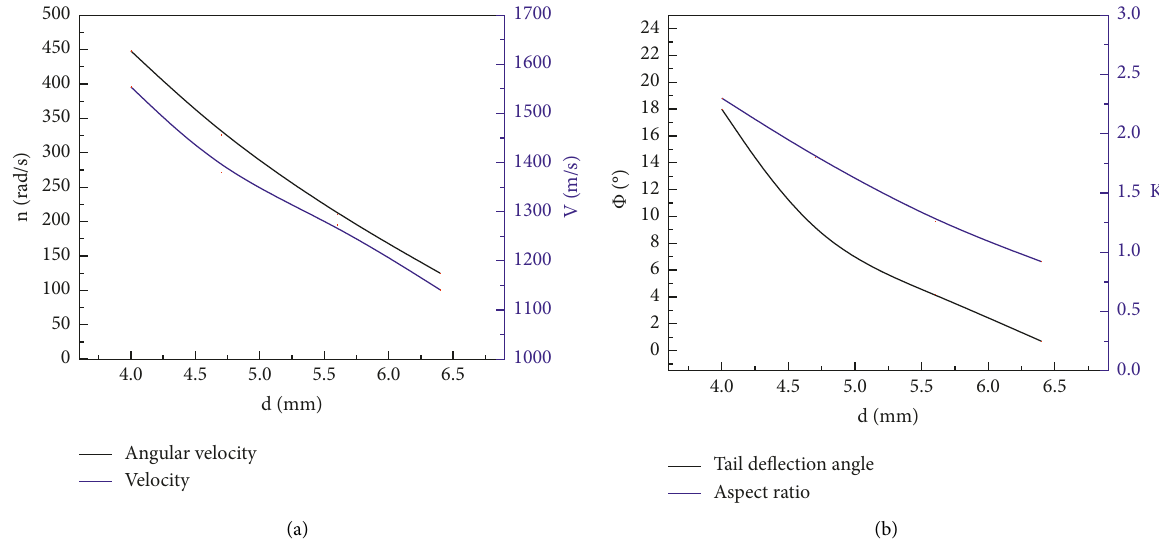
Figure 19: Variations of the angular velocity, axial velocity, tail fin tilt angle, and aspect ratio with the liner wall thickness. (a) Variations of the angular and axial velocities with the wall thickness. (b) Variations of the tail fin tilt angle and the aspect ratio with the wall